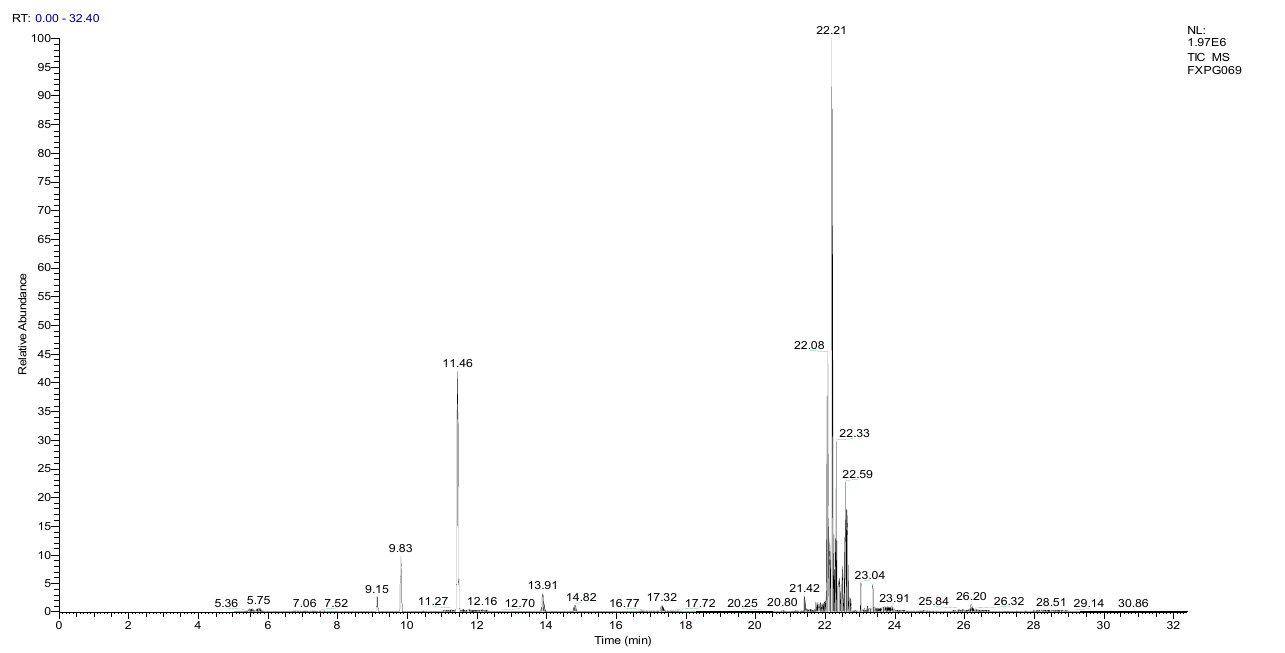
Figure 1. Total ion chromatogram (TIC) of 77 pesticide standards.